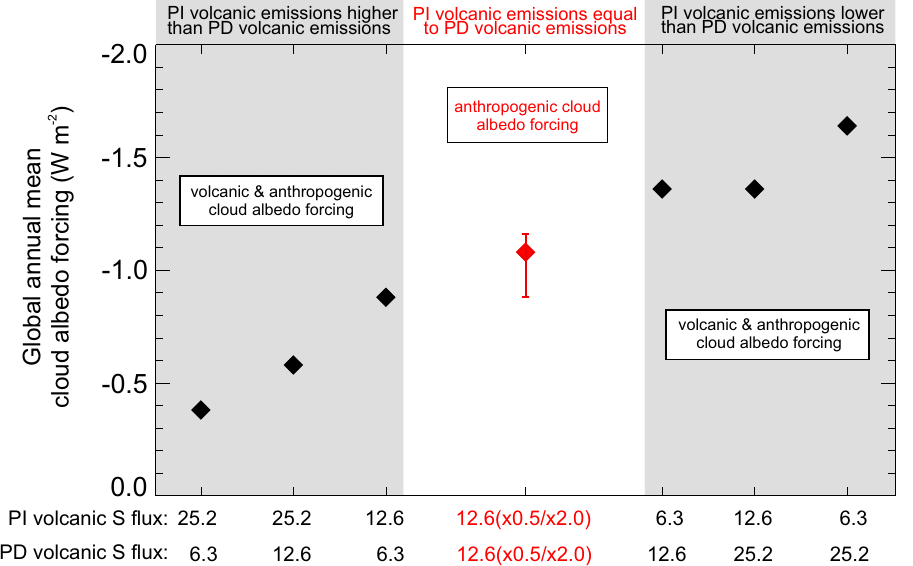
Fig. 8. Effect of the uncertainties in the volcanic sulphur source strength on the anthropogenic cloud albedo forcing. The red symbols show the magnitude and the uncertainty range of the anthropogenic cloud albedo forcing arising from the uncertainty in the volcanic source strength under the assumption that there was no change in the volcanic flux strength between the pre-industrial era (PI) and present-day (PD). The black symbols show the magnitude of the total cloud albedo forcing (i.e. volcanic and anthropogenic) that arise if one assumes differences in the volcanic sulphur flux strength between PI and PD. The x-axis shows the assumptions made about the strength of the volcanic sulphur flux (in Tg ( S ) a − 1 ) for both PI and